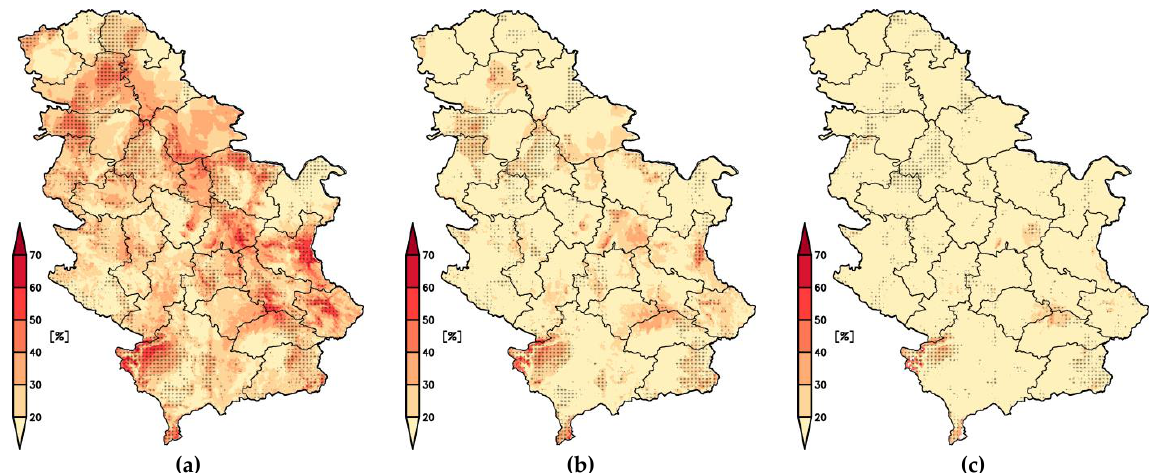
Figure 6. Frequency of years in which at least one day with Tn < −2 °C occurred after the start of the frost-sensitive period for threshold temperature 10 °C ( a ), 11 °C ( b ), and 12° ( c ) in the period 1998–2017. Black dots mark areas where the frequency has increased more than 10% between the periods 1998–2017 and